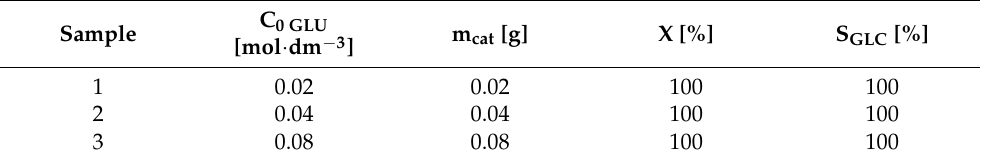
Table 6. Conversion degree of glucose and selectivity to gluconate ions in the reaction of glucose from hydrolysates of cotton in the presence of 5% Pd ‐ 1% Au/SiO 2 catalyst. Reaction conditions: T =